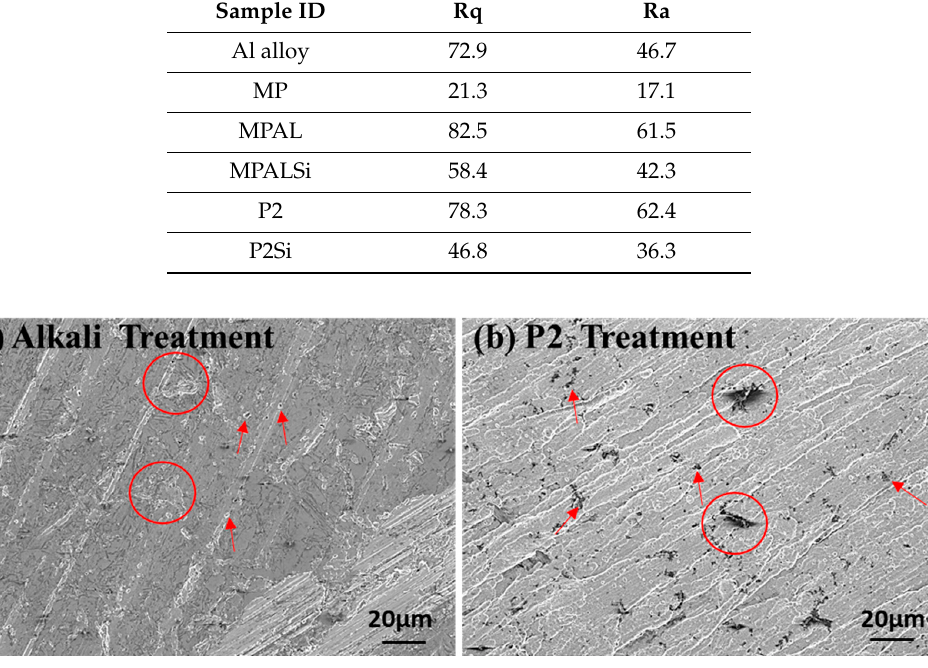
Figure 4. Surface morphology of ( a ) alkali-treated and ( b ) P2 treated Al alloy. Table 3. The roughness data of the different surface modified Al alloy sheets obtained using an atomic force microscope (AFM).